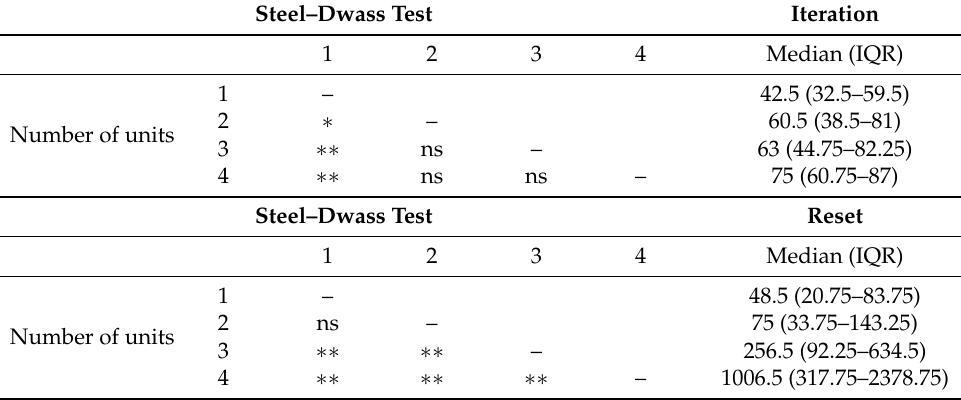
Table 1. Learning characteristics of the QNN concerning the number of units in the hidden layer.